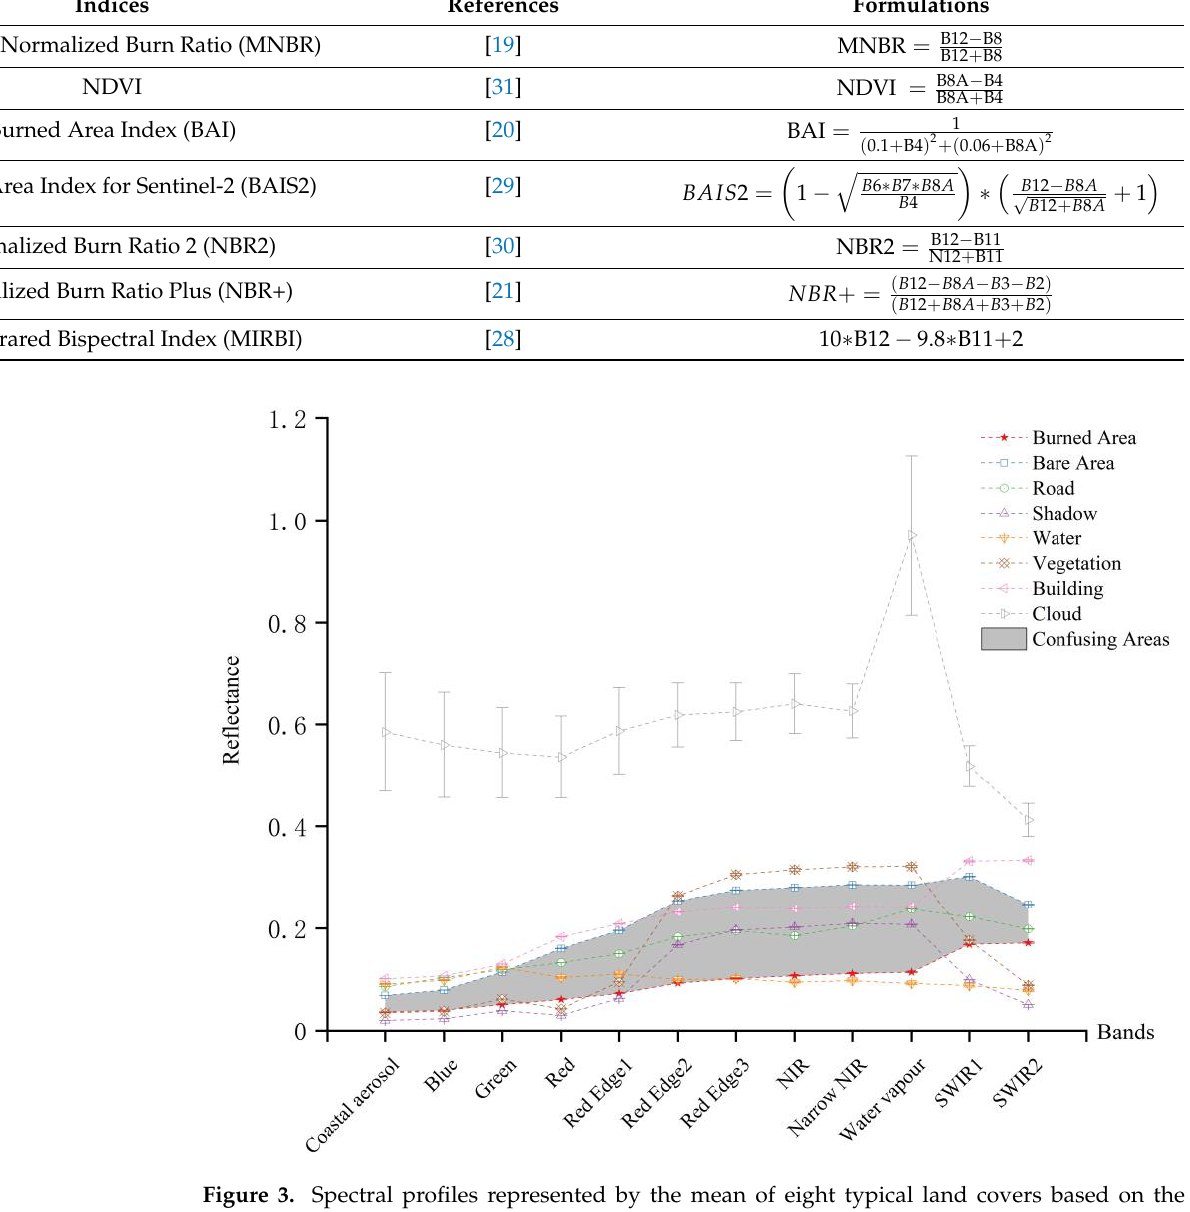
Figure 3. Spectral profiles represented by the mean of eight typical land covers based on the Senti- nel-2 image.